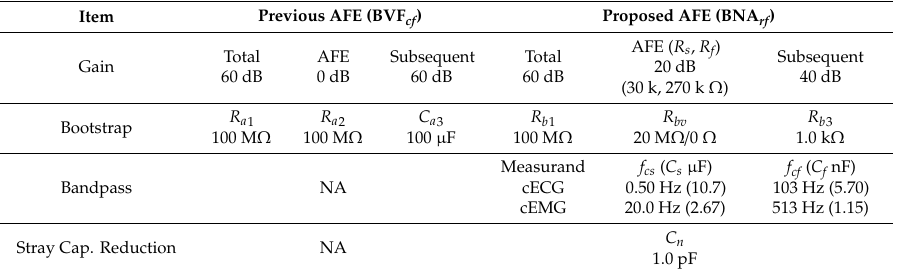
Table 1. Specifications and values of the elements used in the implementation of the previous and proposed AFEs for capacitive electrocardiogram (cECG) and capacitive electromyogram (cEMG) measurements.